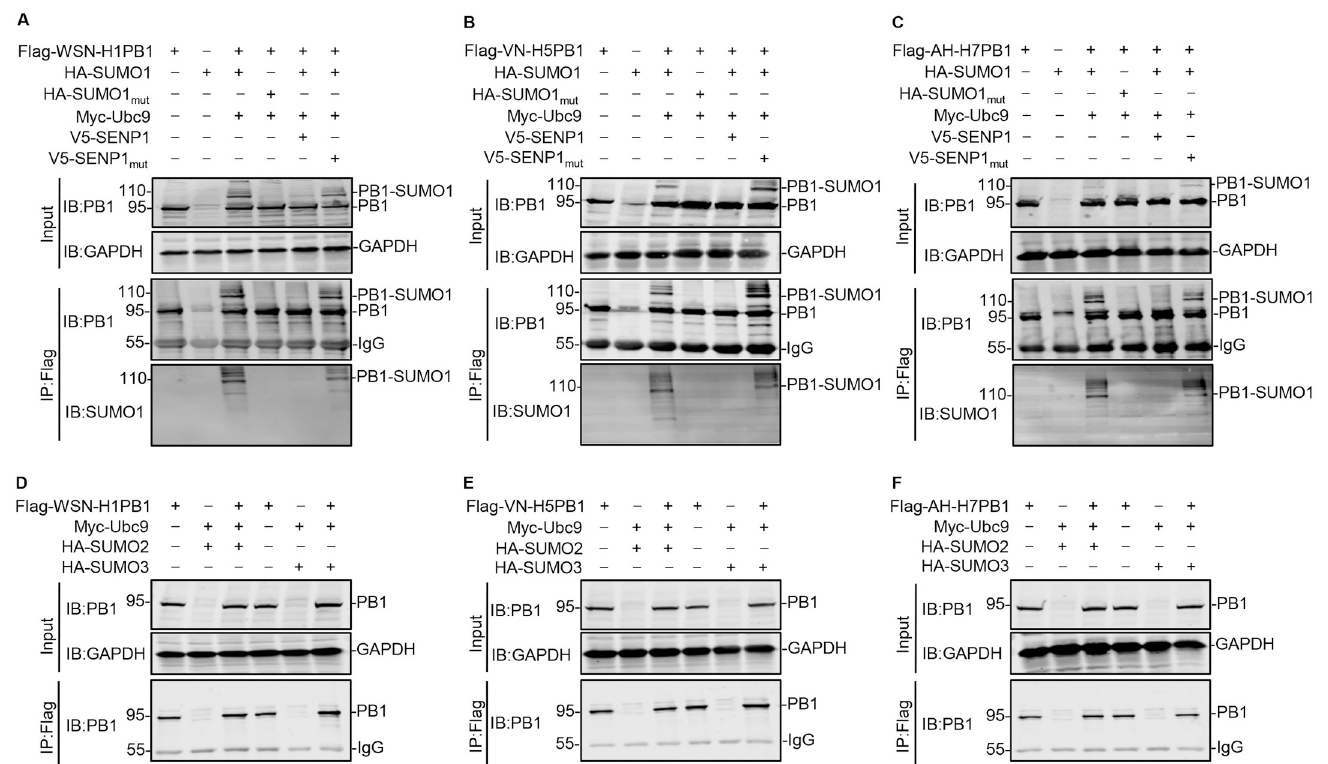
Fig 1. IAV PB1 is mainly SUMOylated by SUMO1. (A-C) HEK293T cells were transfected with plasmids expressing Flag-tagged PB1 from WSN (H1N1) (A), VN/ 1180 (H5N1) (B), or AH/1 (H7N9) (C), together with or without SUMO1 or SUMO1 mut , Ubc9, and SENP1 or SENP1 mut . At 48 h post-transfection, cell lysates were prepared, immunoprecipitated with anti-Flag M2 agarose beads, and western blotted to detect PB1 and SUMO1 with the indicated antibodies. (D-F) HEK293T cells were transfected with plasmids encoding Flag-tagged PB1 from WSN (H1N1) (D), VN/1180 (H5N1) (E), or AH/1 (H7N9) (F), together with or without Ubc9, and SUMO2 or SUMO3. At 48 h post-transfection, cell lysates were prepared, immunoprecipitated with anti-Flag M2 agarose beads, and western blotted to detect PB1 with an anti-PB1 mAb. The values on the left of the blots are molecular sizes in kilodaltons of the corresponding bands. Data shown are representative of three independent